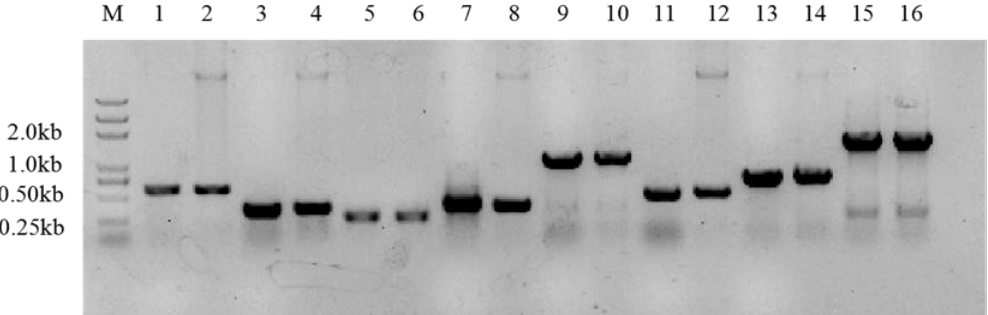
Figure 6. Verification of extracellular polysaccharide-producing genes. M, 2 kb marker; 1, gene #152; 2, Positive control of gene #152; 3, gene #1371; 4, positive control of gene #1371; 5, gene #4312; 6, positive control of gene #4312; 7, gene #1802; 8, positive control of gene #1802; 9, gene #2164; 10, positive control of gene #2164; 11, gene #3901; 12, positive control of gene #3901; 13, gene #7310; 14, positive control of gene #7310; 15, gene #2936; 16, positive control of gene #2936.